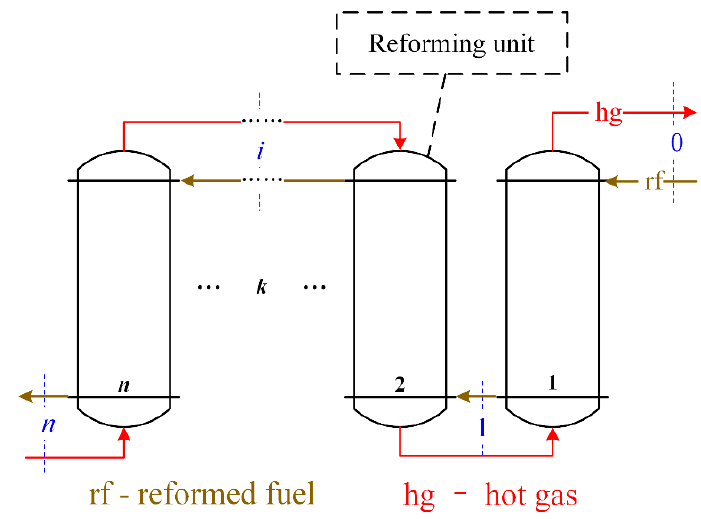
Figure 2. Arrangement of the chemical reformer.